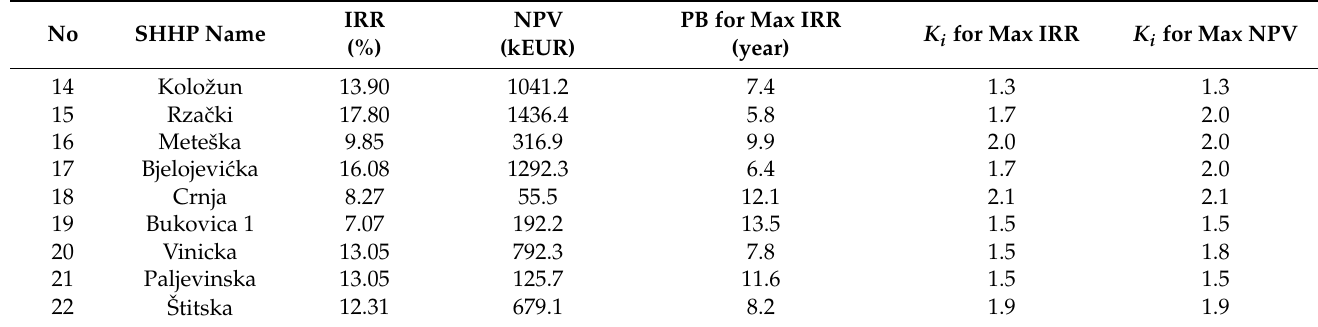
Table 8. Typical examples for Group II.